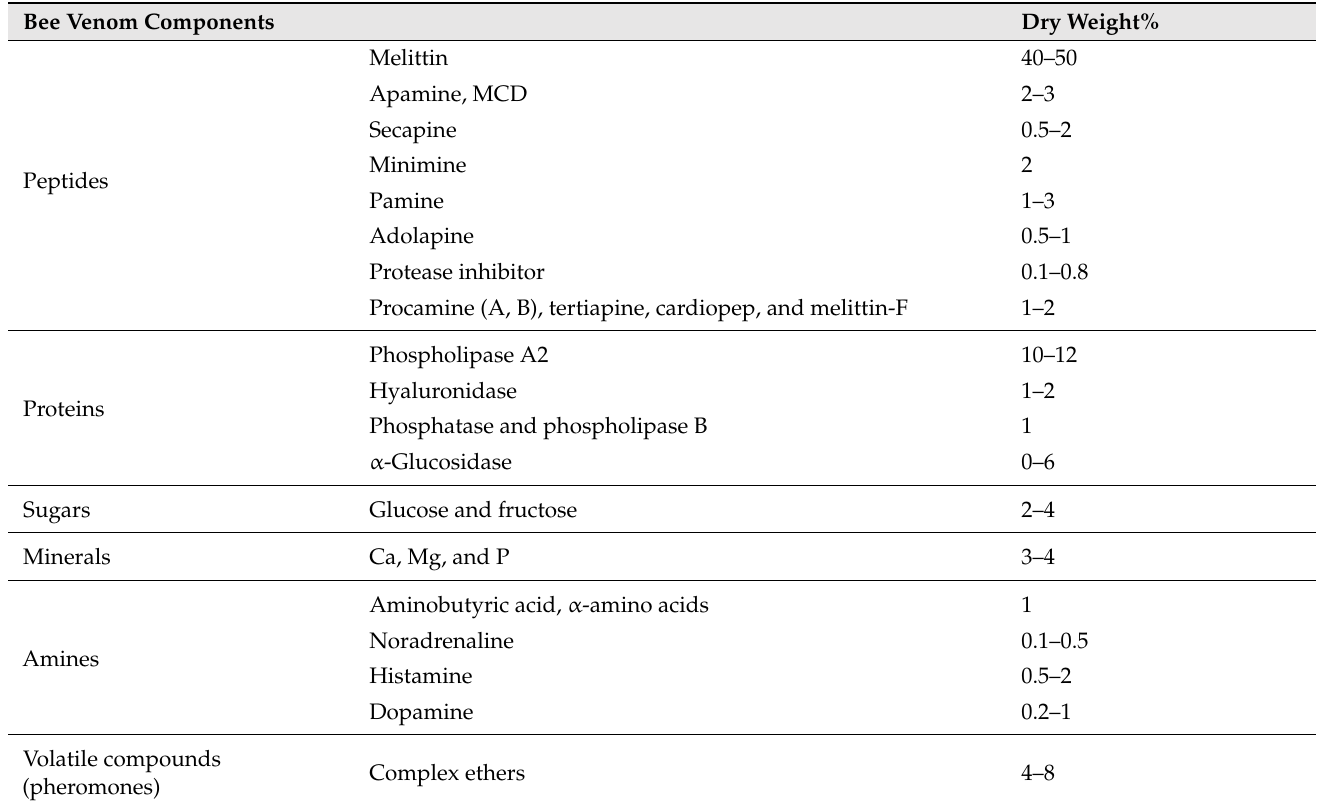
Table 4. Chemical components of bee